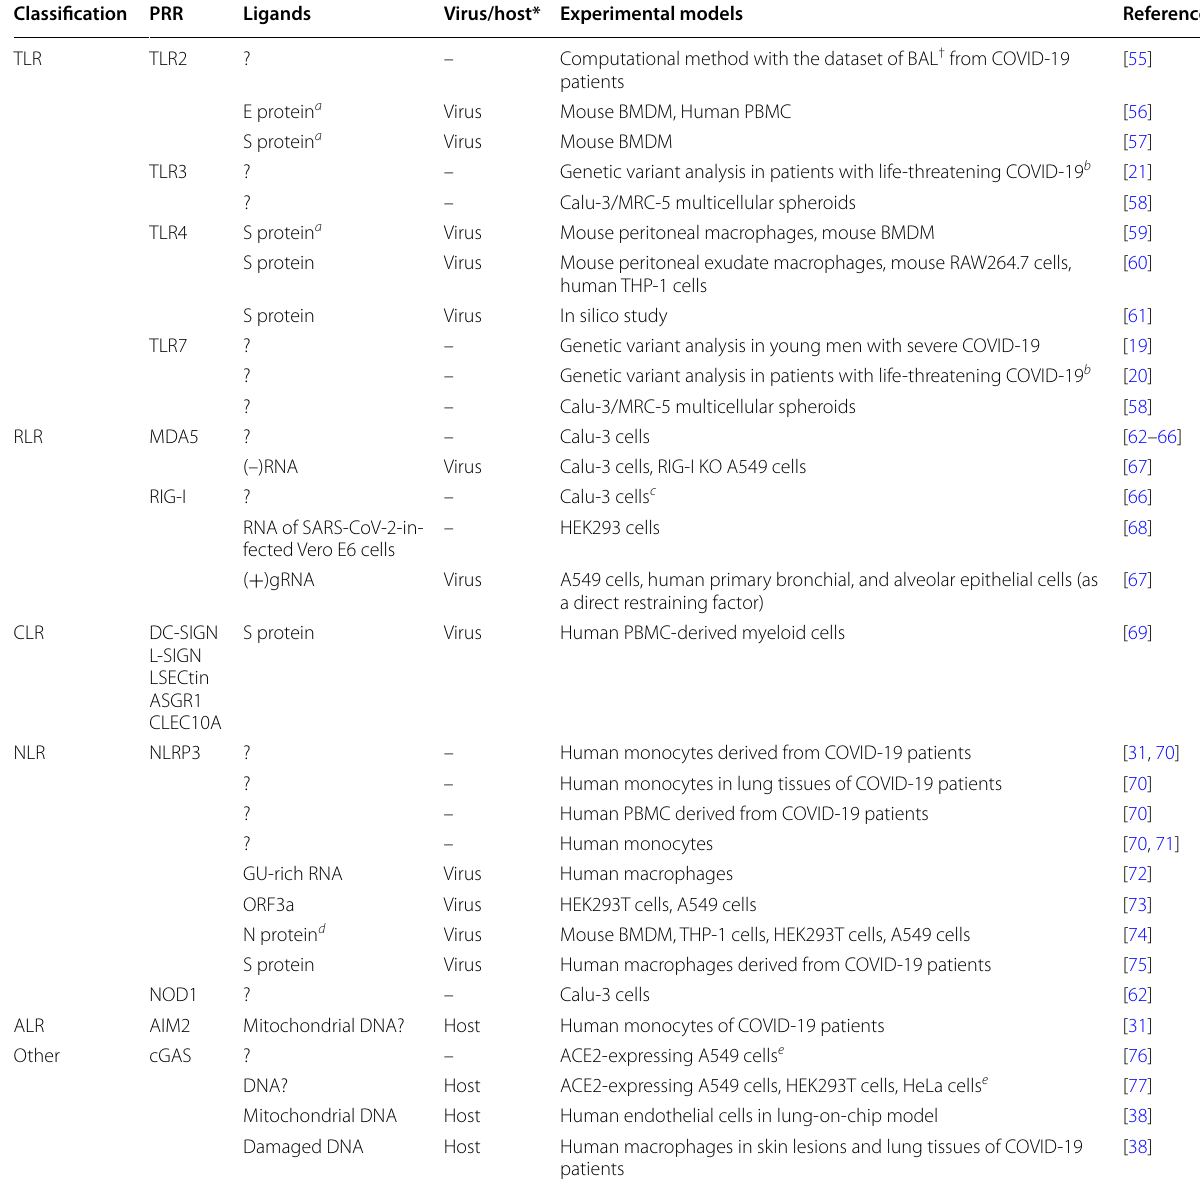
Table 1 Pattern recognition receptors for SARS-CoV-2